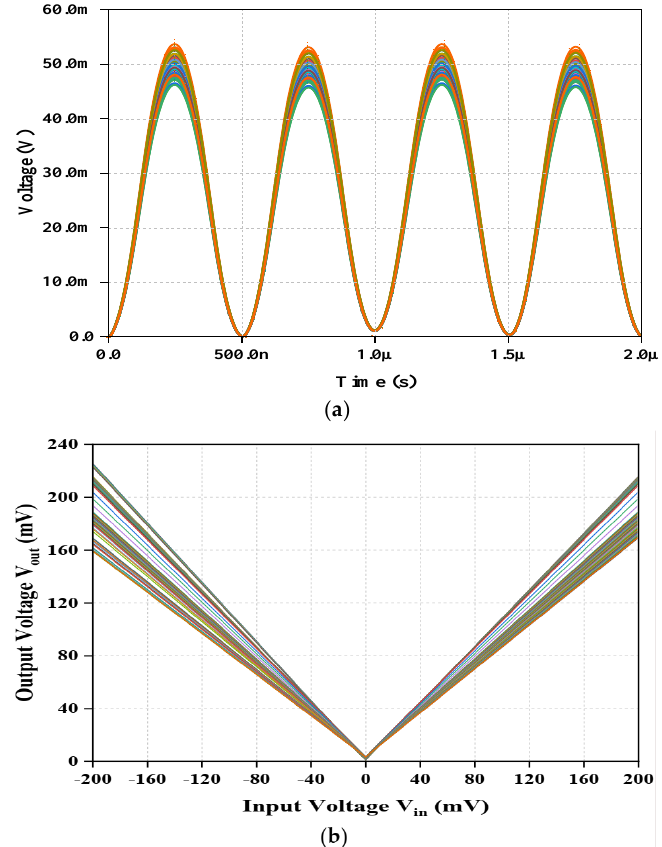
Figure 11. Monte Carlo sampling response of the presented rectifier circuit ( a ) Time response ( b ) Input-output DC